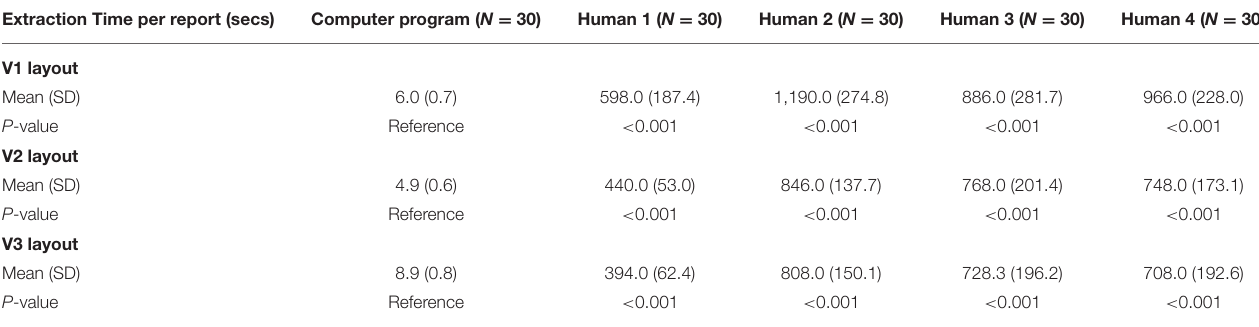
TABLE 2 | Extraction times for each resolution layout.